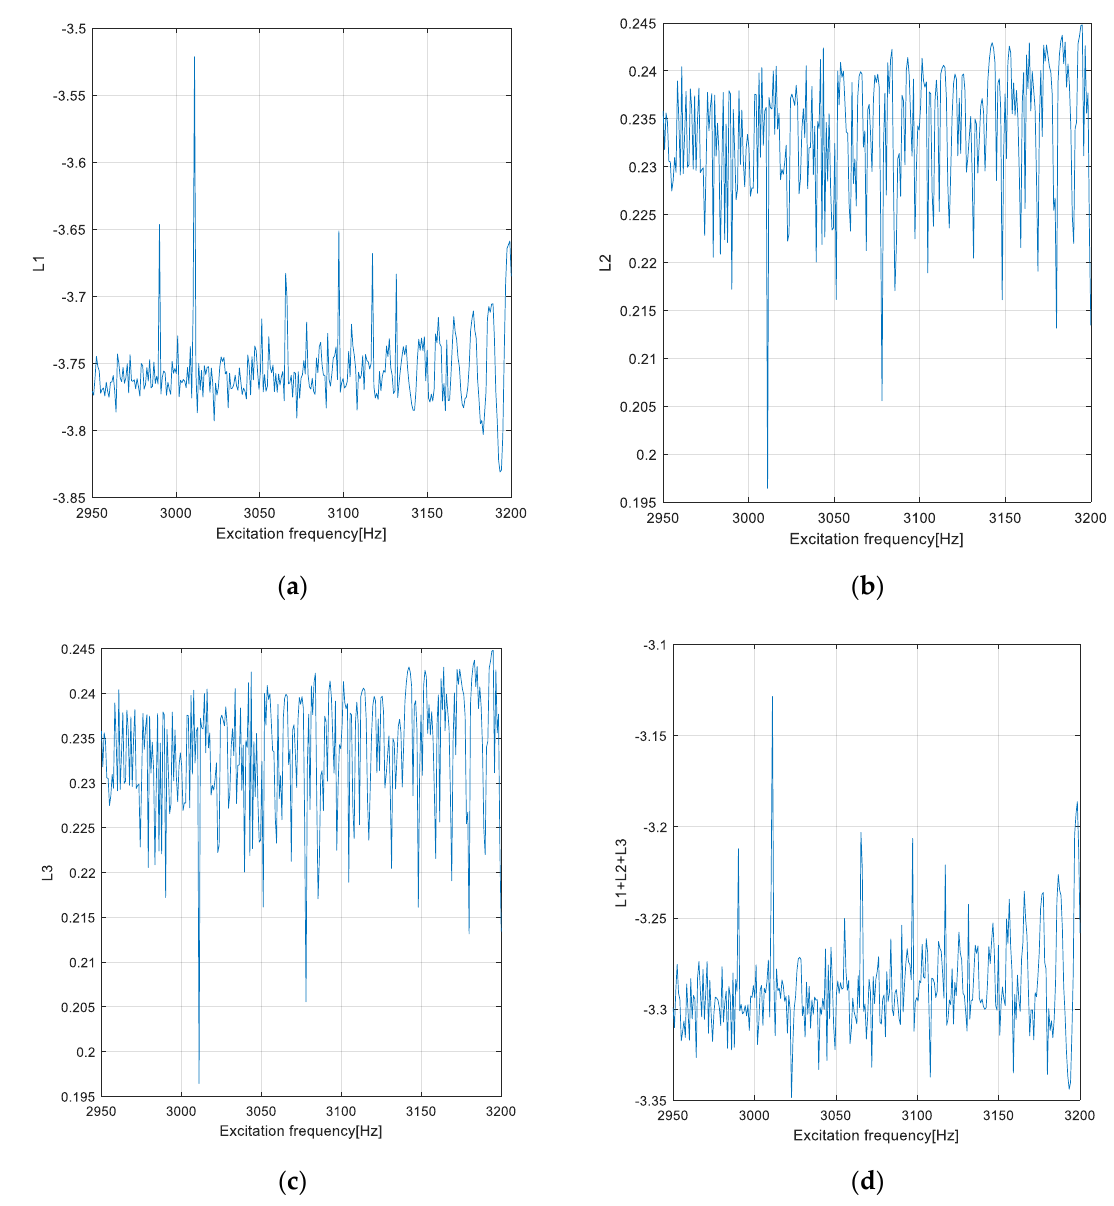
Figure 18. Lyapunov exponents of NFTV for DIE1, β = 9 0 , ξ = 7.3 · 10 − 3 . 1 As can be seen from the Figures 17–20 in (a) is presented the graph variation of the Lyapunov exponent L 11 (see Equation (31), to verify the criteria (37)), in (b) is illustrated the graph variation of the Lyapunov exponent L 21 ( see Equation (32), to verify the criteria (37)), in (c) is shown the graph variation of the Lyapunov exponent L 31 ( see Equation (33), to verify the criteria (37)), and in (d) is presented the graph variation of the sum of Lyapunov exponents L 11 + L 21 + L 31 (in order to apply the criteria (39)), for the nonstationary FTV of DIE1 in transition through the PPRR, namely for excitation frequency in the range [2950,3200]